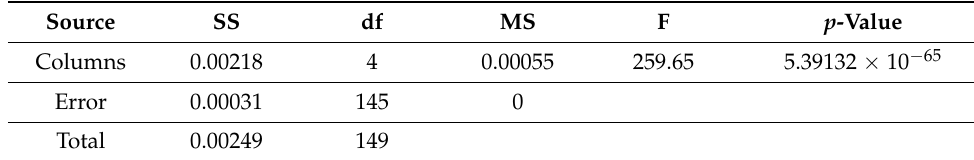
Figure 7. Tukey ranking for control.